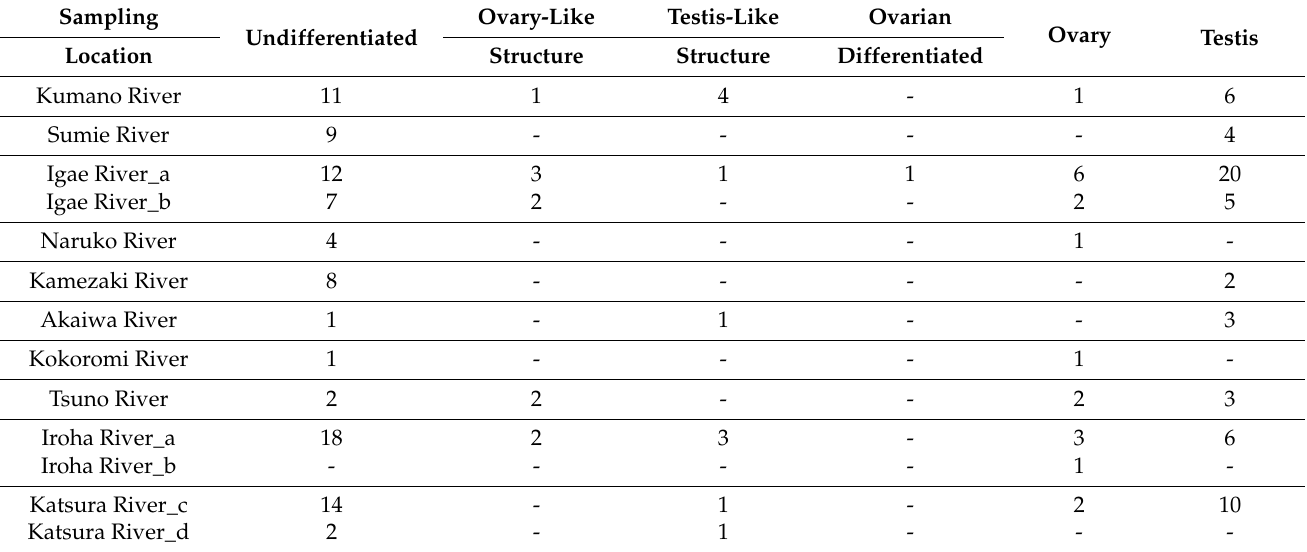
Table 2. The number of eels sampled in each river, and gonadal development